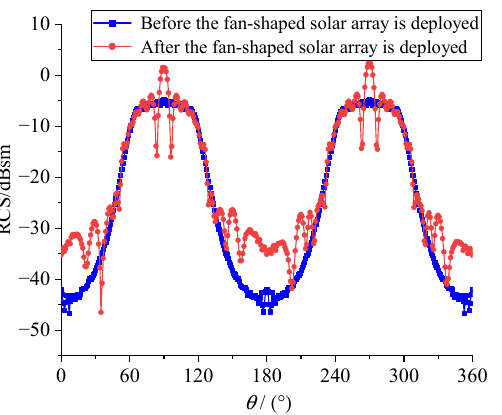
Figure 10. The schematic of incident wave.